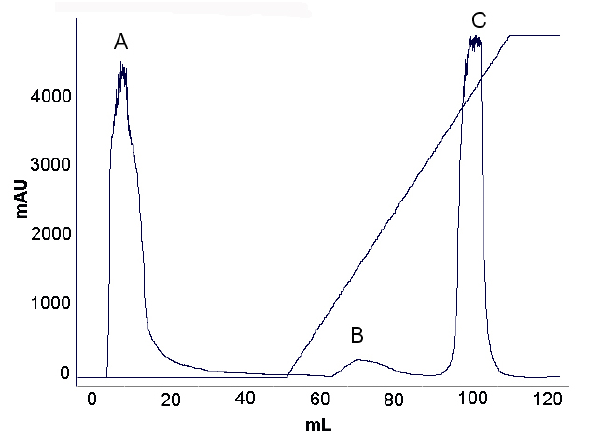
Figure 1 . Fractionation of hemolytic crude extract by anion exchange chromatography. H. magnifica crude extract, dissolved in 10 mM sodium phosphate buffer (pH 7.4), was fractionated by DEAE- Sepharose® anion-exchange chromatography using a flow rate of 60 mL/hour. Peak A, corresponding to washout fractions, showed hemolytic activity.